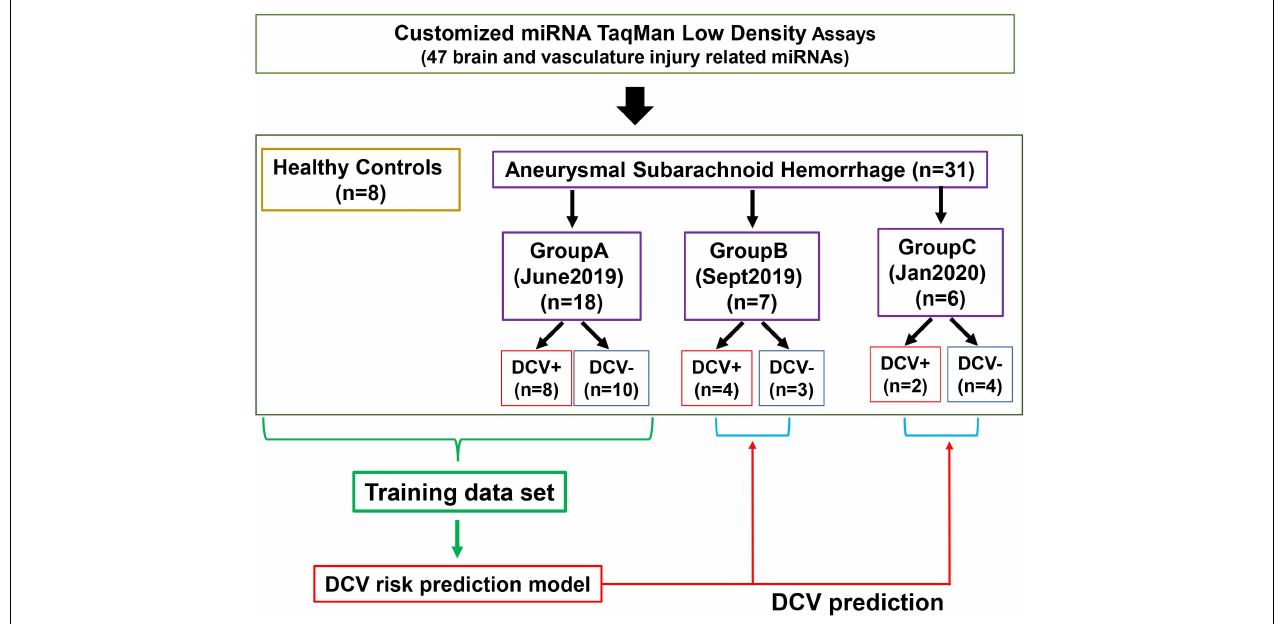
FIGURE 1 | Flowchart of patient groups and sample analysis. DCV: delayed cerebral